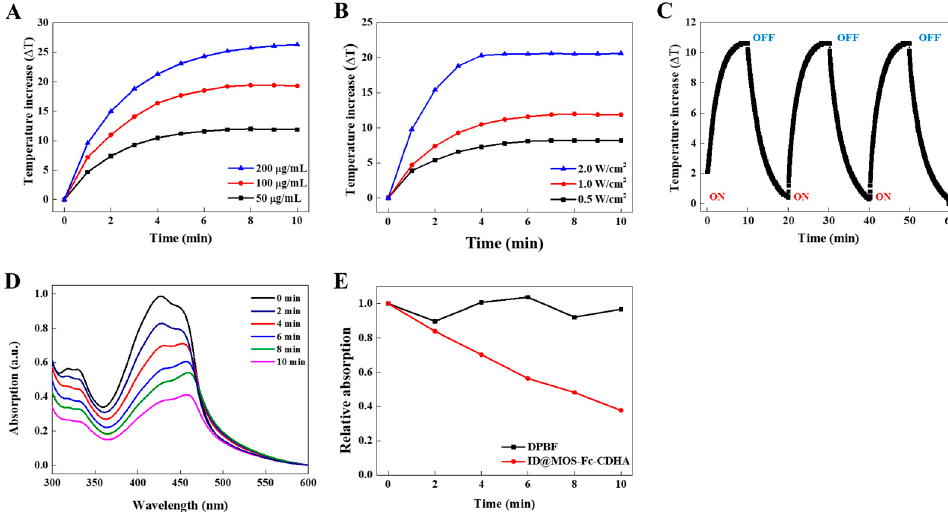
Figure 3. Photothermal and photodynamic performances of the ID@MOS-Fc-CDHA nanocomposites. ( A ) Temperature changes of the ID@MOS-Fc-CDHA nanocomposites with various concentrations under a 808 nm NIR laser (1 W/cm 2 ). ( B ) Temperature curves of ID@MON-Fc-CDHA with different laser power densities (0.5–2.0 W/cm 2 ). ( C ) Photostability of the ID@MON-Fc-CDHA (50 µ g/mL) nanocomposites after three NIR laser on/off cycles of a 808 nm NIR laser irradiation (1 W/cm 2 , 10 min). ( D ) UV-vis spectra of the DPBF solution including the ID@MOS-Fc-CDHA